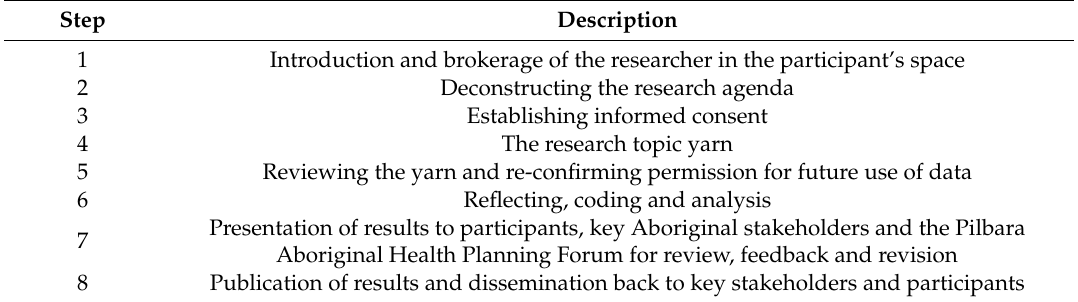
Table 1. Yarning as methodology. Steps used in ‘Having a quiet word’: yarning with Aboriginal women in the Pilbara Region of Western Australia about mental health and mental health screening in the perinatal